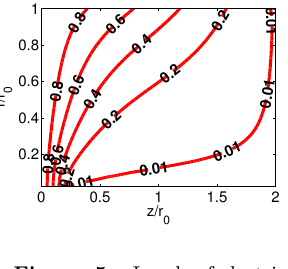
Figure 6. Maximal temperature depending on time t by β = 0 . 5 ,P 1 = 0 . 01 ,P 2 = 0 . 1.